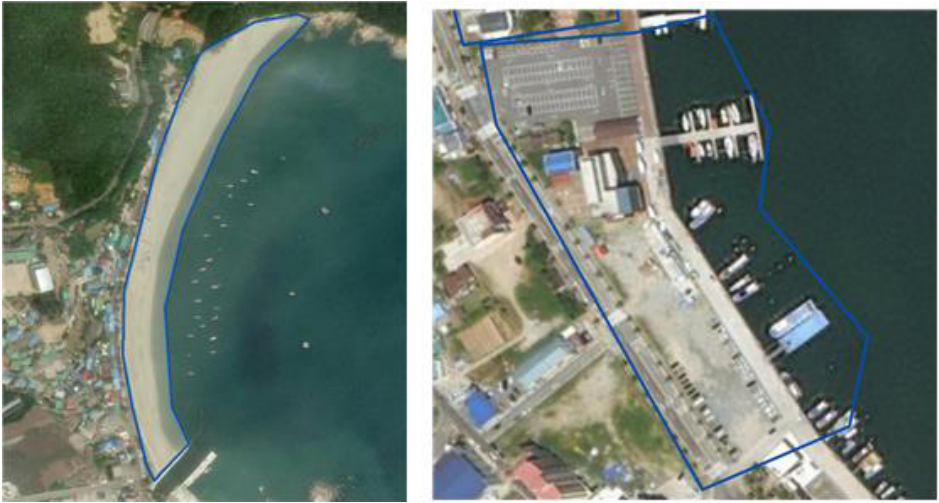
Figure A1. Examples of spatialization of major coastal tourist attractions. Table A1. Information by attraction type of coastal tourism visitation data.